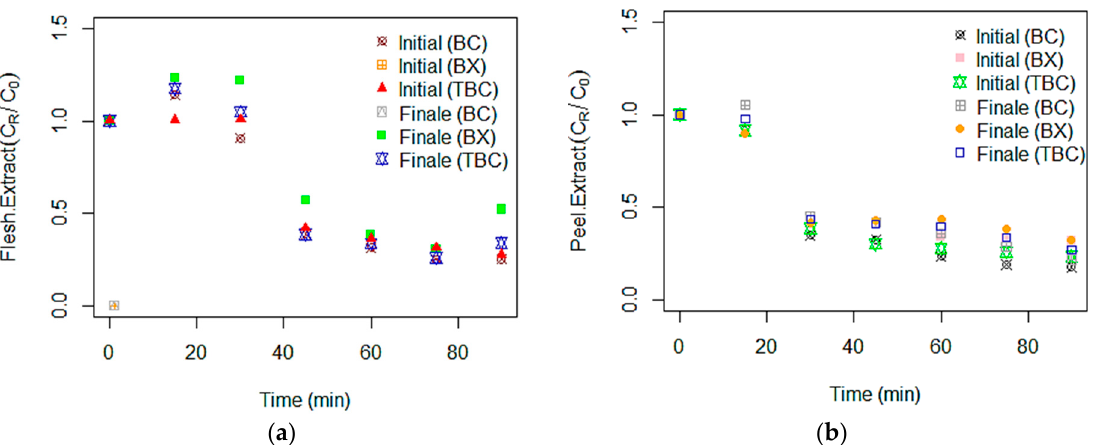
Figure 7. Concentration ratios of betalains in concentrations of beetroot flesh ( a ) and peel ( b ) at different heating times.